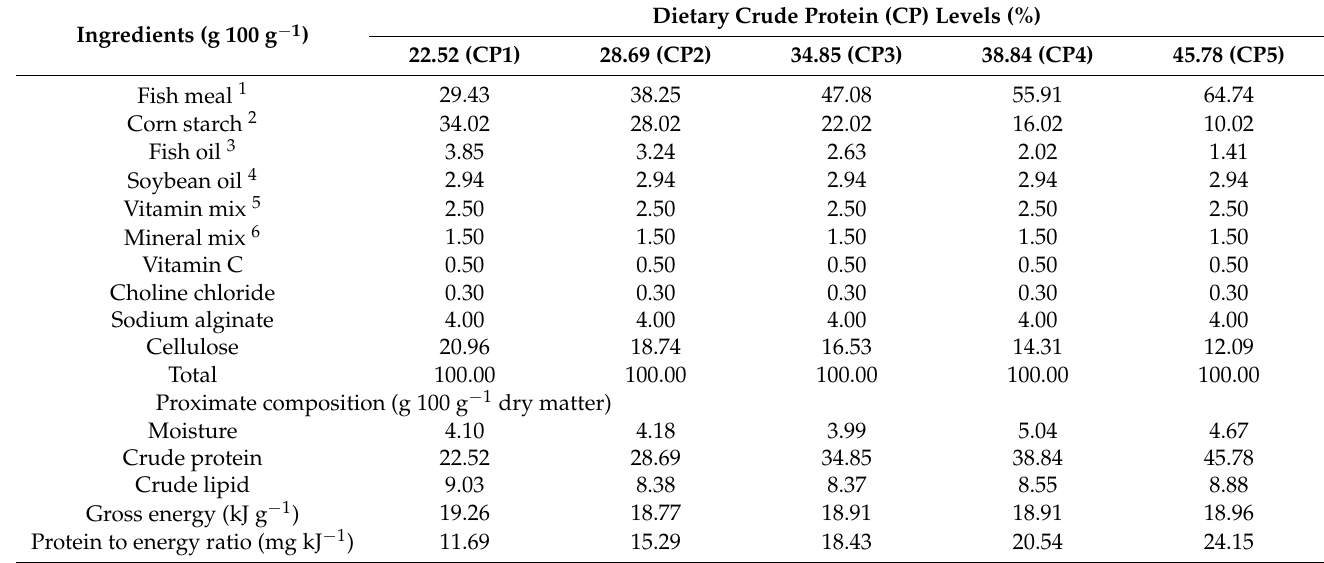
Table 1. Formulation and composition of experimental diets (% as dry matter